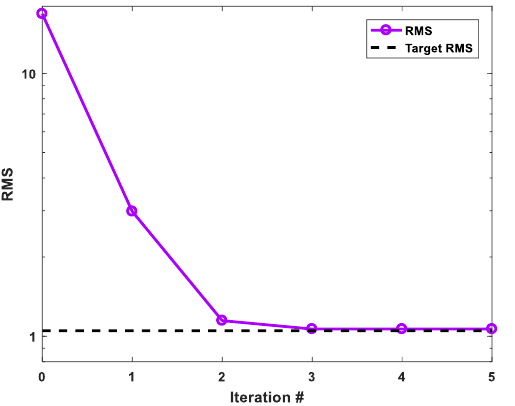
Figure 4. Convergence plot for the SM3 model. The black dashed line indicates the threshold RMS.